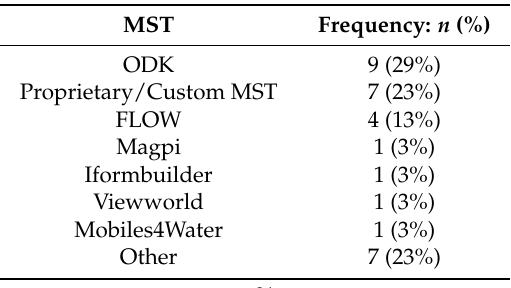
Table 2. MSTs used by survey